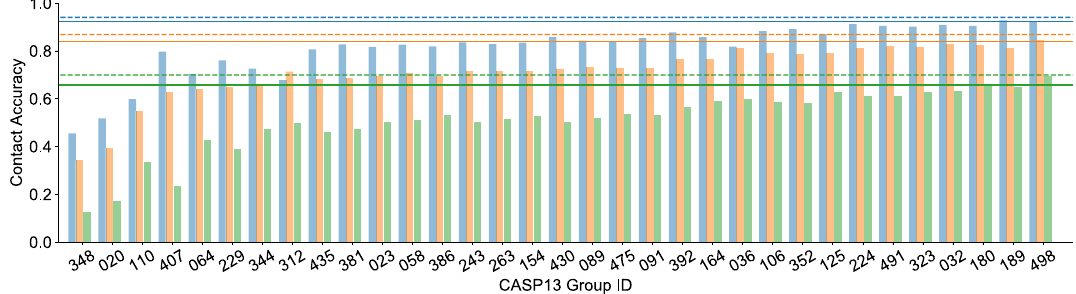
Figure 2. Comparison of average contact prediction accuracies for groups from the CASP13 RR category. Accuracies for short, mid, and long contact ranges are shown in blue, orange, and green, respectively. Group IDs can be mapped to authors using the CASP13 groups page 25 . Solid lines represent the average accuracies of predictions made with an ensemble of all 33 groups shown. Dashed lines show average prediction accuracies for an ensemble consisting of only the top 20% of all groups shown (7 right groups) as determined by average contact accuracy across all three ranges.